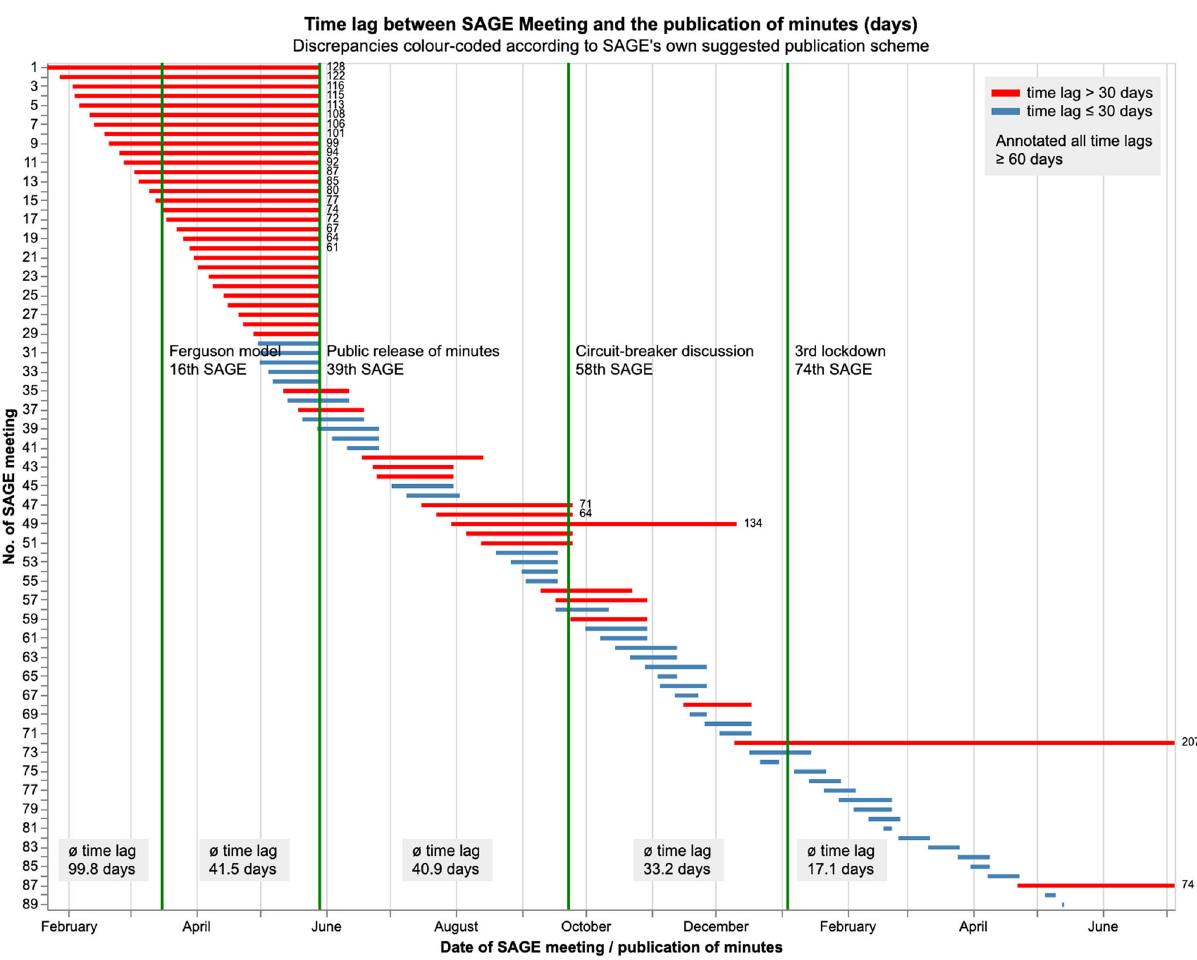
Fig. 2 Discrepancy between the date of SAGE meetings and publication of meeting minutes according to gov.uk. Red indicates meeting minutes published 30 days after the meeting. Diagram inspired by the fi gure in Haddon et al. (2020, p. 42). This updated version uses meeting and publication data provided in Supplementary Information 5. Original data source: SAGE Meeting Minutes (1 – 89) from UK Government